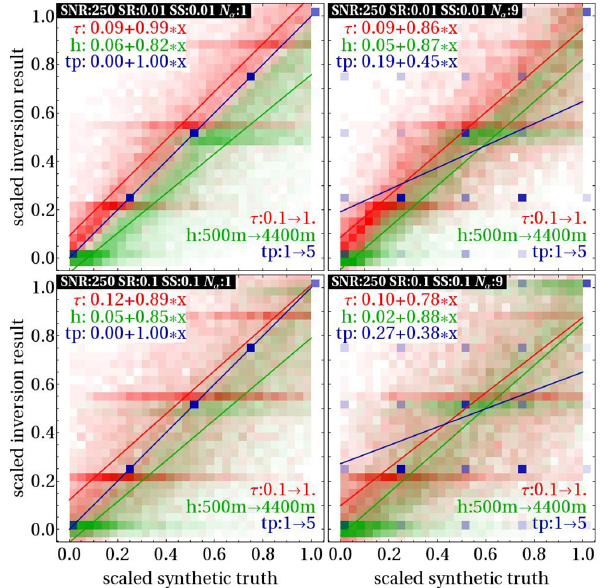
Figure 9. Overview about inversion runs for various scenarios. Each figure is a combined scatterplot of a retrieved and prescribed pa- rameter for 10 000 randomly selected cases. A scenario is defined by signal to noise level, spectral width, spectral sampling, number of surface reflectances, and aerosol type background information. These background settings are shown in the top left of each fig- ure, and an SNR value of 500 was used here. Also in the top left shown are line parameters for a linear fit per parameter, and the true parameter interval is shown in the bottom right. Shown are re- trieval results for the aerosol optical thickness (red), aerosol height (green), and aerosol type (blue). No interpolation between aerosol types was used, and types were ordered like in Table 1 (0 . 0 = dust, 0 . 25 = urban, 0 . 5 = continental, 0 . 75 = neutral, 1 . 0 = absorbing). The left column shows results for the the best case (aerosol type in- formation known, homogeneous surface with N α = 1) and the right column for the realistic case (unknown aerosol type, inhomoge- neous surface with N α = 9) scenario. From top to bottom the spec- tral resolution (SR) and sampling (SS) are decreased from 0 . 01nm (top) to 0 . 1nm (bottom). The color scale follows an inverse power distribution to enhance the visibility of low-density bins.